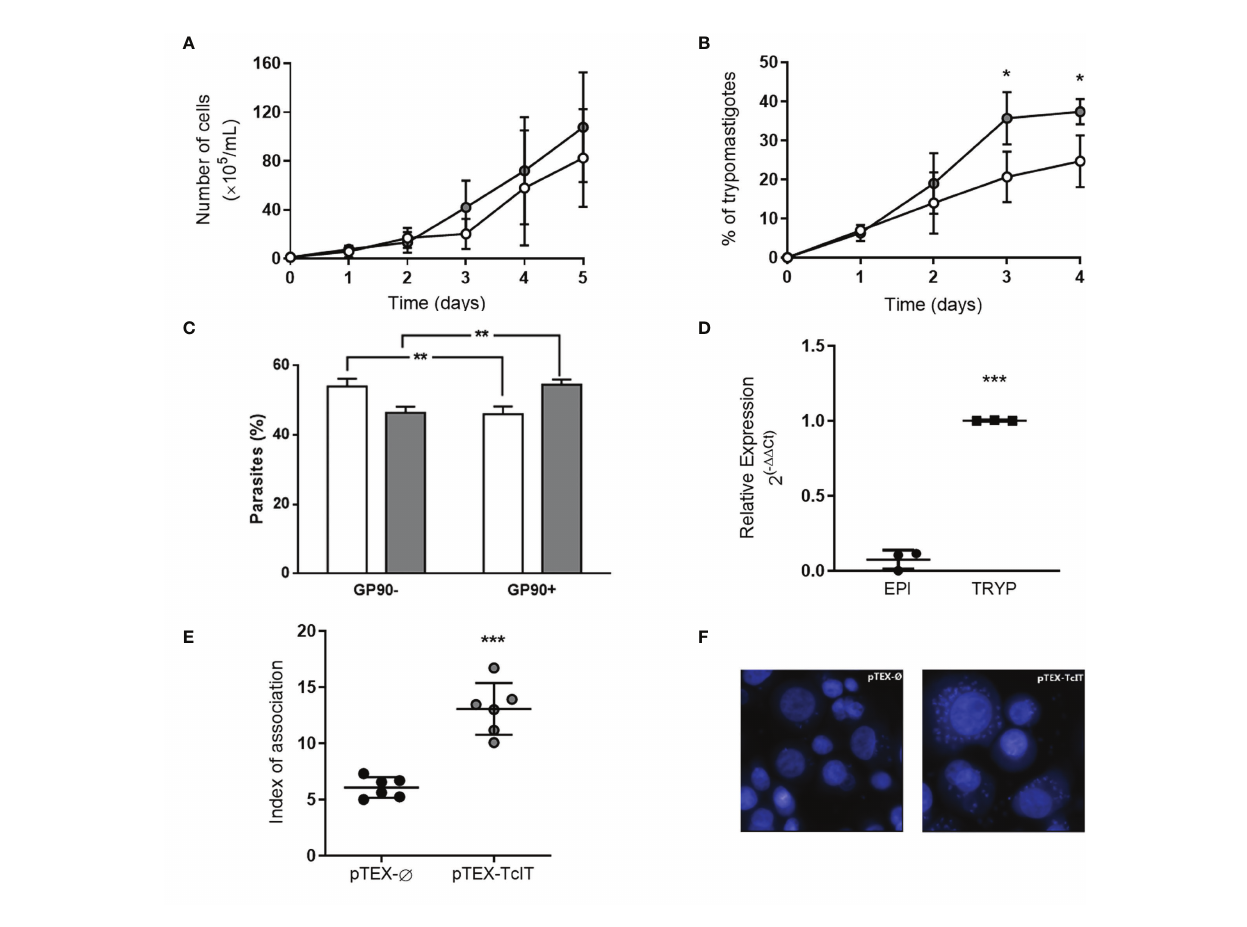
FIGURE 6 | TcIT overexpression in fl uences T. cruzi differentiation to trypomastigotes, but not proliferation. (A) T. cruzi epimastigotes transfected with pTEX-Ø empty vector (white circles) or pTEX-TcIT plasmid (gray circles) proliferation. Epimastigotes of T. cruzi at mid-log phase were harvested, washed twice, seeded into fresh medium, and grown for the indicated times in regular medium under the antibiotic pressure of G418 (50 mg/ml) ( n = 6). (B) Transfected epimastigotes with empty vector pTEX-Ø (white circles) or pTEX-TcIT (gray circles) were exposed to in-vitro differentiation medium TAU. Each day, epimastigotes and trypomastigotes were differentially counted to determine the percentage of trypomastigotes in culture; * P < 0.05 ( n = 4). (C) Cytometric analysis of parasites after the 4th day in TAU (B) using the 1G7 antibody against the marker of metacyclogenesis GP90. (D) Quanti fi cation of the TcIT transcript in T. cruzi epimastigotes (EPI) or trypomastigotes (TRYP). Quantitative PCR used 100 ng cDNA from mutants, as indicated on the abscissa; *** P < 0.001 ( n = 3). (E) Index of association estimated by total number of intracellular parasites per infected LLC-MK2 cells. *** P < 0.001 ( n = 6). (F) Representative images of pTEX-Ø or pTEX-TcIT parasites infection in LLC-MK2 cells, quantitatively compared in (E) . Except for (C) , using Student ’ s t -test assessed the differences between mean values. In (A, B) , the differences were assessed by comparing time-matched determinations. In (C) , the comparisons were performed by using two-way ANOVA. ** P < 0.01 ( n =